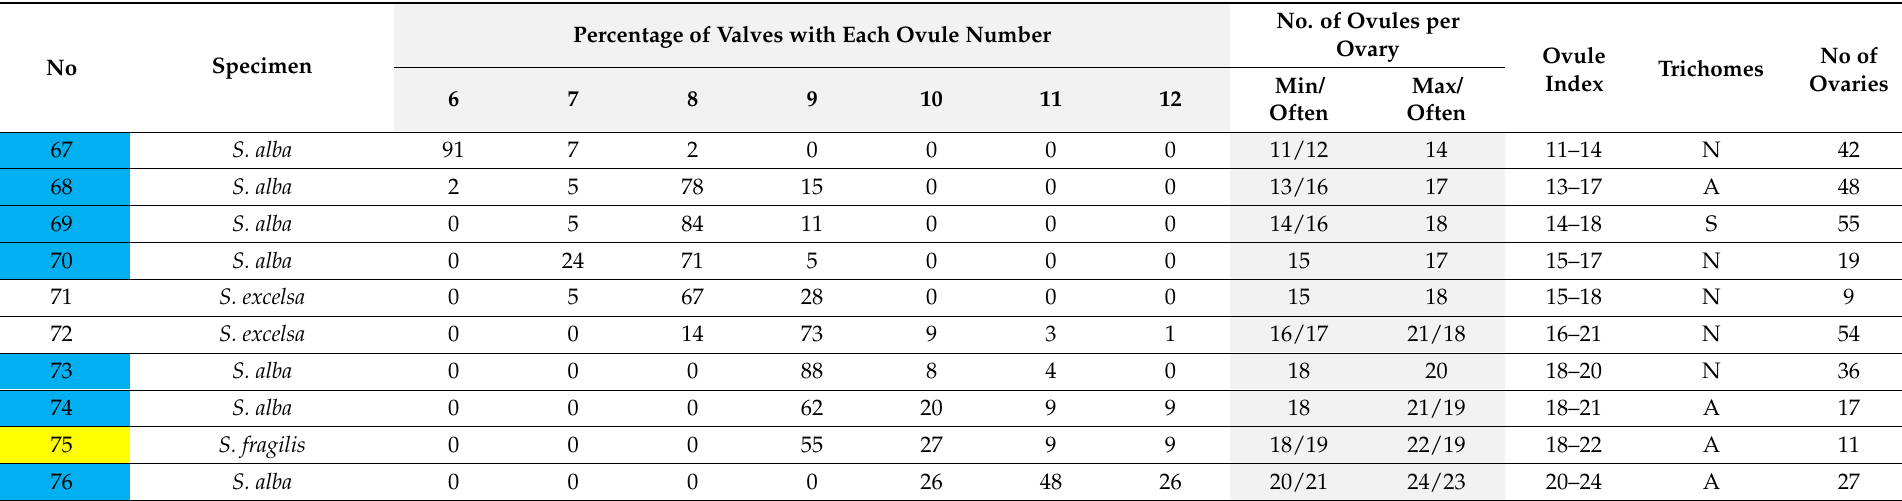
Table 3. The ovule data for Salix alba, S. fragilis and S excelsa with 6 to 12 ovule/valve. Each capsule in Salix has 2 valves and the presented data include the percentage of valves in a catkin with different numbers of ovules. The additional characteristics are included: the number of ovules per ovary (min/often and max/often), the ovule indices (the minimum and maximum number of ovules per ovary), presence of trichomes at bract apex (A—bracts abscised; N—none; S—short), and number of studied ovaries. The entries with the specimens’ numbers (column 1) were colored according to their names based on their original identification—blue for S. alba , yellow for S. fragilis , white for S. excelsa —for visual presentation of the species’ distribution throughout the